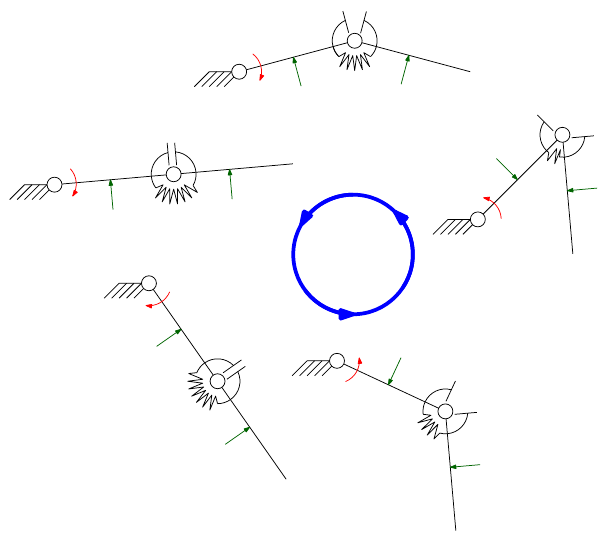
Figure 8. General motion of a self-adaptive flapping wing, the green curved arrows indicate the resistance of the fluid while the red straight arrow symbolize